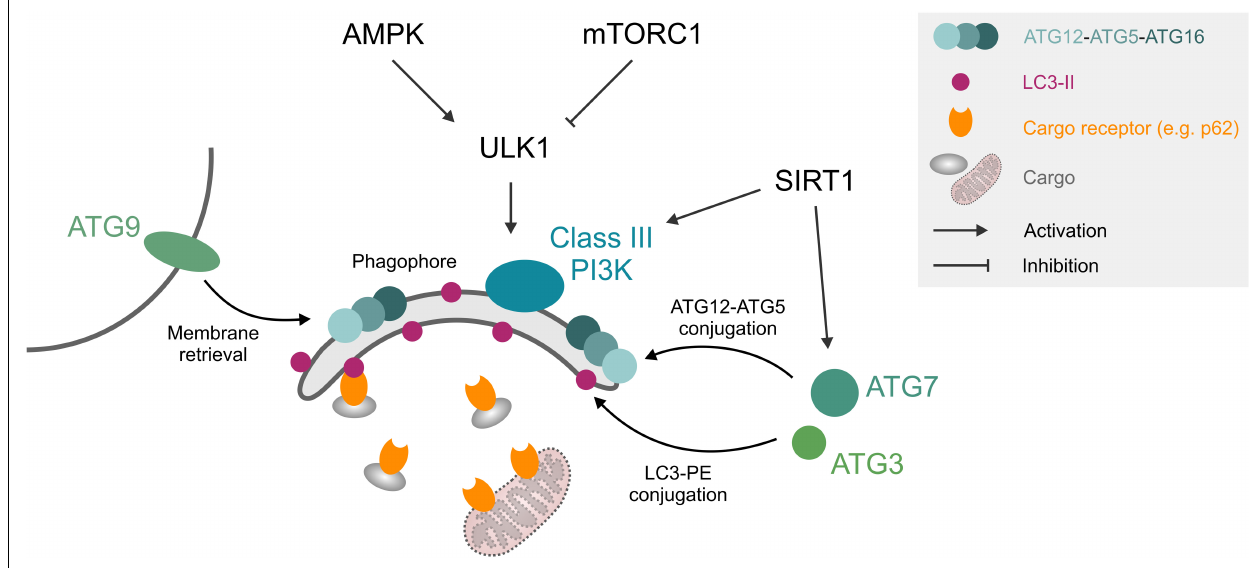
FIGURE 1 | Autophagy core machinery. Upstream nutrient/growth factor signaling and cellular energy status regulate mTORC1 and AMPK kinases, respectively, which in turn inhibit or activate ULK1 through different phosphorylation sites. ULK1 phosphorylates components of the phagophore formation machinery, consisting of a class III PI3K complex, ATG12-ATG5-ATG16 complex, ATG9, and LC3-II. LC3-II can interact with cargo (e.g., protein aggregates) through cargo receptors such as SQSTM1/p62 or organelles like mitochondria through mitochondrial surface markers. ATG3 and ATG7 mediate ATG12-ATG5 and LC3-PE conjugation. SIRT1 deacetylates and activates several ATG proteins. See text for details. Abbreviations: LC3-II, microtubule-associated protein light chain 3 (lipidated form); PE, phosphatidylethanolamine; PI3K, phosphatidylinositol 3 kinase; ULK1, Unc-51-like kinase